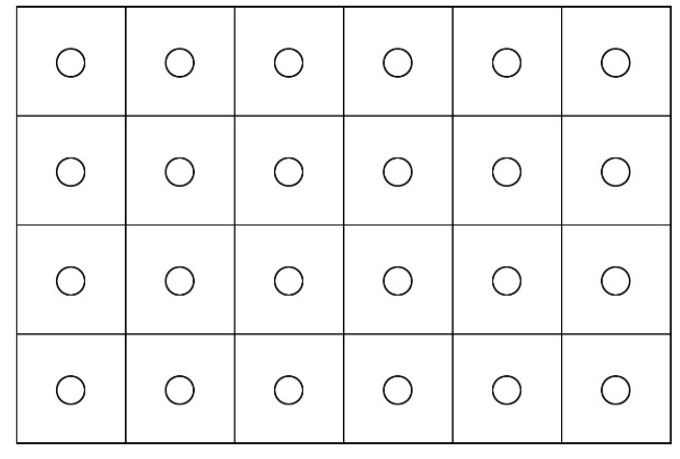
Figure 1. Lighting center arrangement.